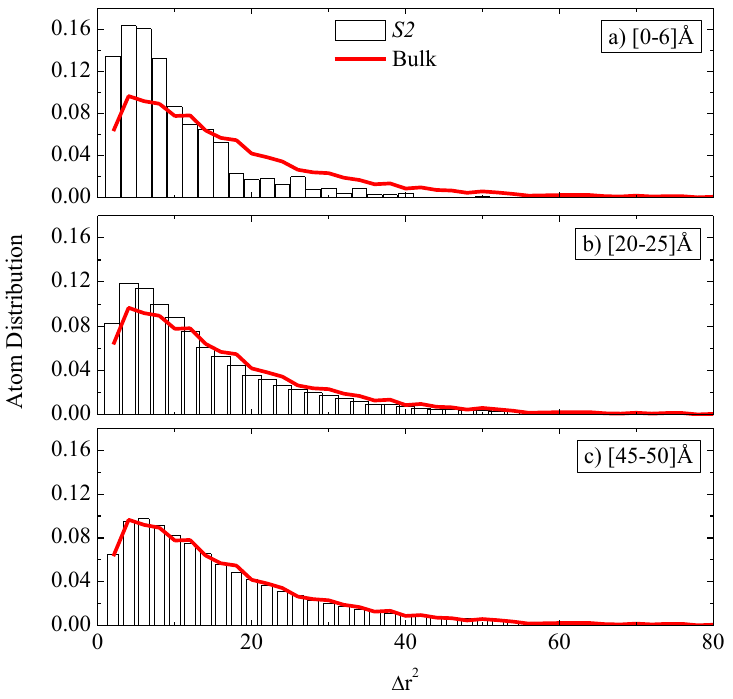
Figure 9. Probability distribution of the mean squared displacements, g j (τ), for the S2 system at a specific time period (τ = 5 ps) for three different radial regimes: ( a ) 0–6 Å; ( b ) 20–25 Å and ( c ) 45–50 Å. In all cases the distribution of a bulk system is shown with a solid